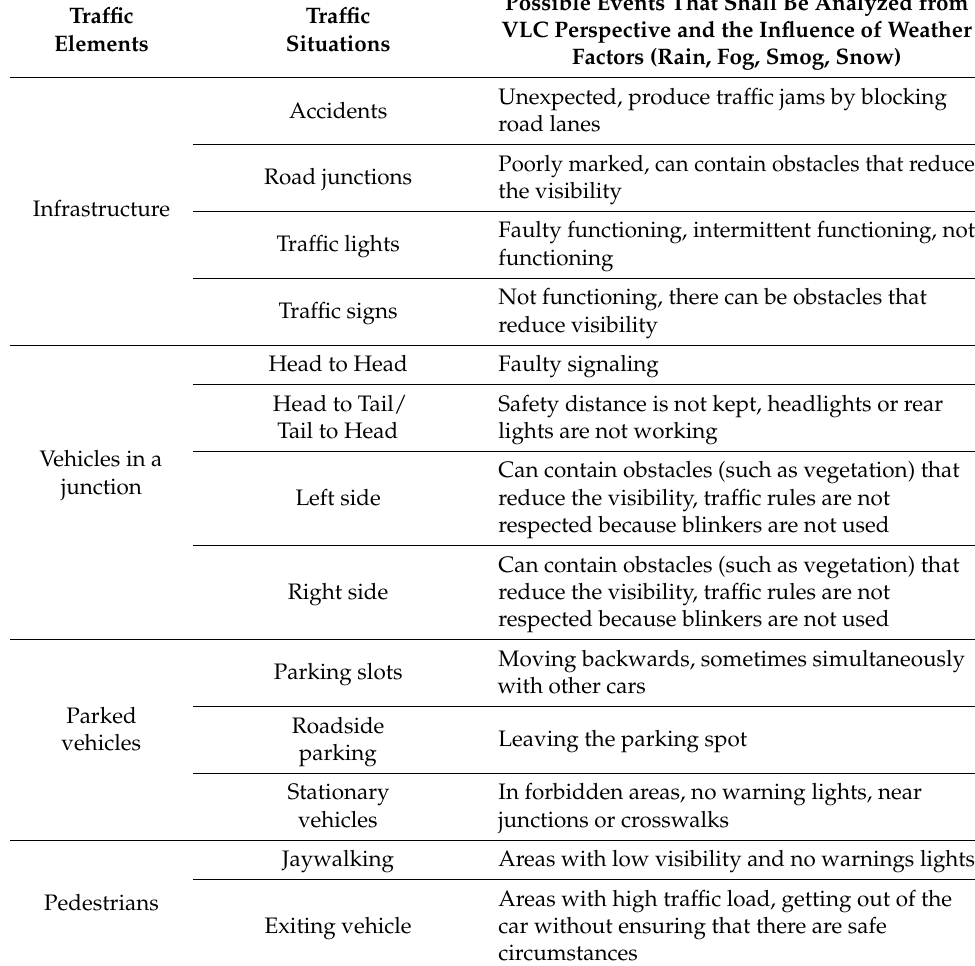
Table 4. Overview of VLC patterns and potential applications.